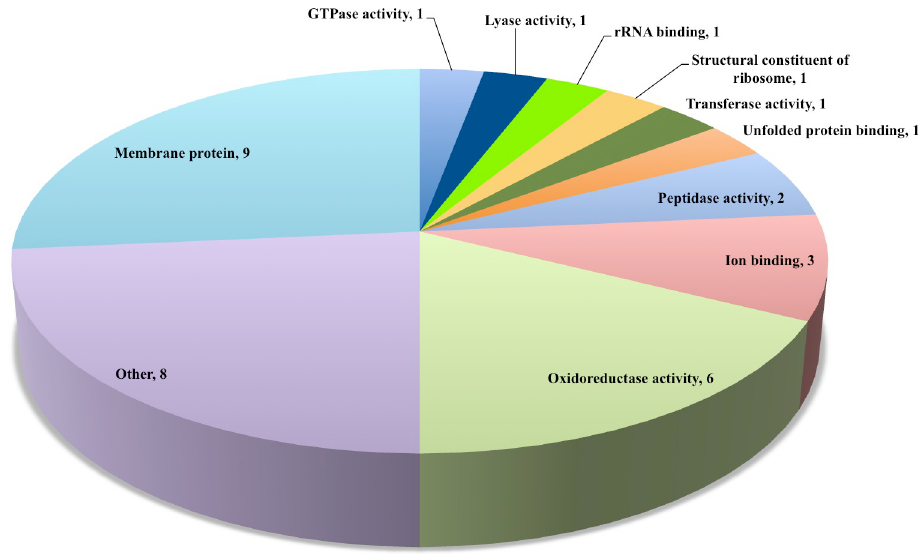
Fig 1. Distribution of P . torridus secretory proteins according to their functional categories.